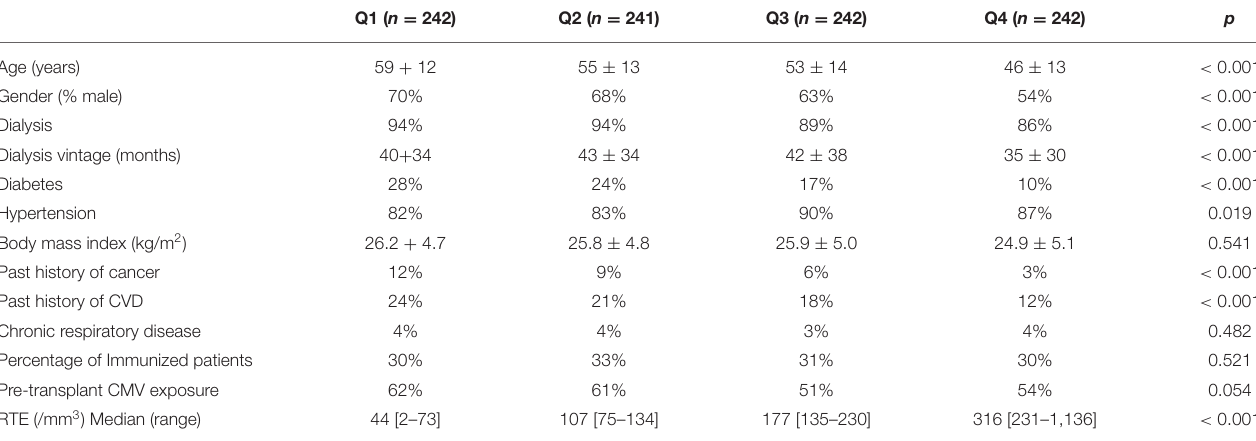
TABLE 2 | Clinical characteristics of the study population according to RTE